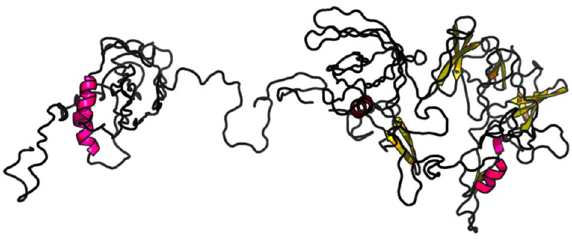
Figure 7. Vaccine 3D Structure Modeling by RaptorX based on the template with PDB ID 3j3vC. All the 694 amino acids in the final vaccine are modeled. The P-value of this model is 4.13 × 10 − 14 and this very low value indicates high quality of this 3D model. The unnormalized Global Distance Test (uGDT) score of this model is 506 (> 50), indicating good absolute model